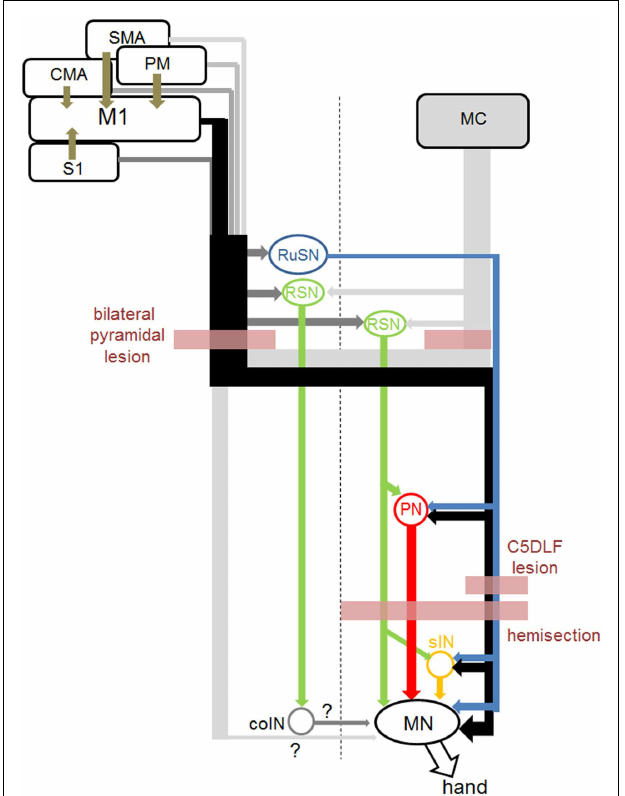
FIGURE 1 | Direct and indirect pathways from the sensorimotor cortices to hand motoneurons, and sites of lesion in the studies cited in this review . Connection from the midline-crossing axons from the contralateral corticospinal tract and commissural interneurons (coINs) was not clarified before (marked as “?” in this figure). Connection from the RuSNs to the PNs and sINs, and that from the RSNs to PNs were demonstrated in cats, but not in primates